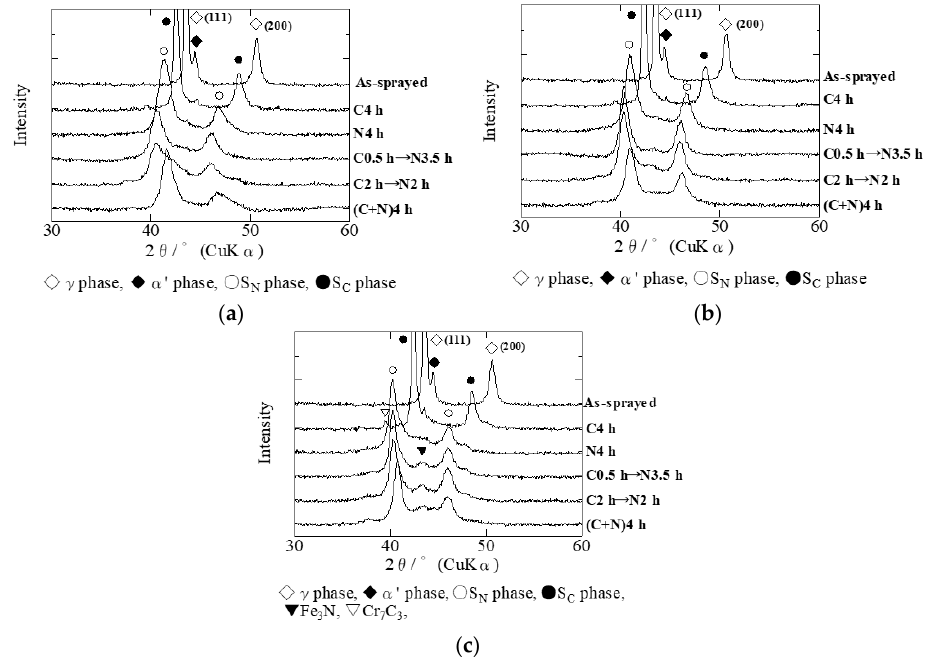
Figure 2. X-ray diffraction patterns of the cold-sprayed AISI 316L samples subjected to low-temperature plasma treatments at ( a ) 400 °C, ( b ) 425 °C and ( c ) 450 °C.